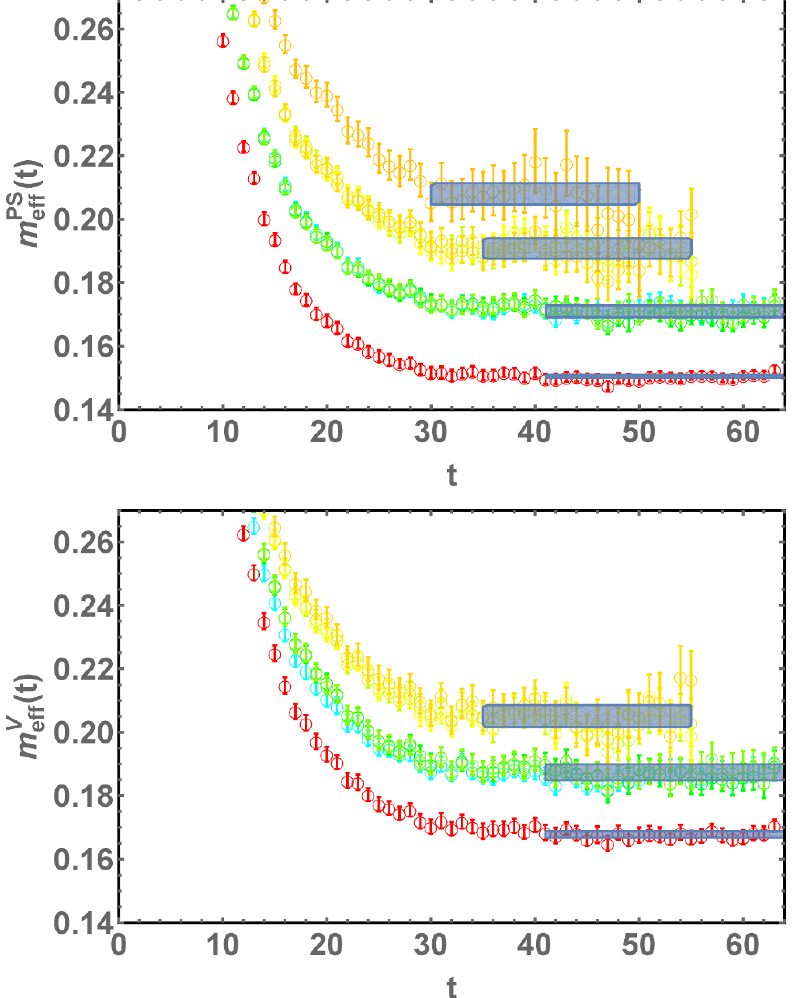
Figure 4 . E(cid:11)ective mass plots for a pseudoscalar meson m PS green, yellow, brown colors represent di(cid:11)erent momenta j ~n j = 0 ; 1 ; 2 ; 3, respectively. The blue bands denote the ground state energies obtained by (cid:12)tting the e(cid:11)ective mass to a constant in the asymptotic region. The lattice bare parameters used in these plots are (cid:12) = 2 : 0, m 0 = (cid:0) 0 : 2, (cid:24) 0 = 4 : 7, (cid:24) 0 = 4 : 7, and N t (cid:2) N 3 = 128 (cid:2) 12 3 g s f